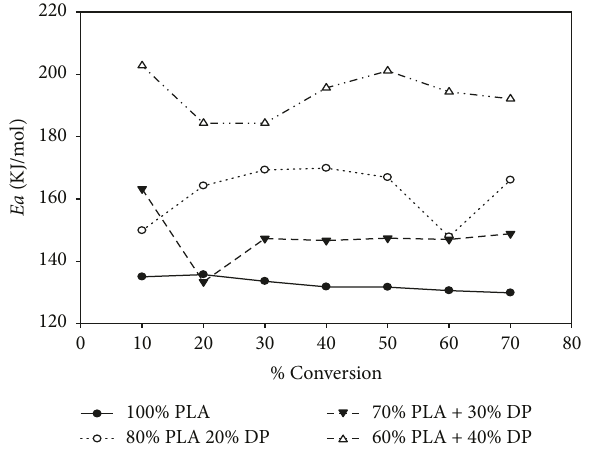
Figure 15: Degradation mechanism of different PLA